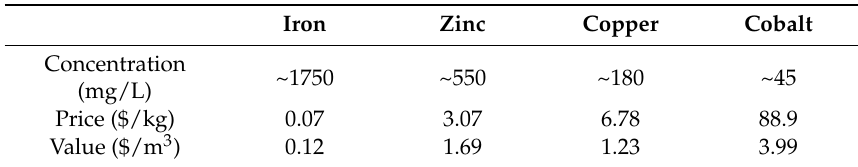
Table 3. The comparison of the values (in $ US, May 2018 commodity prices) of the major transition metals present in the Rio Tintillo ,